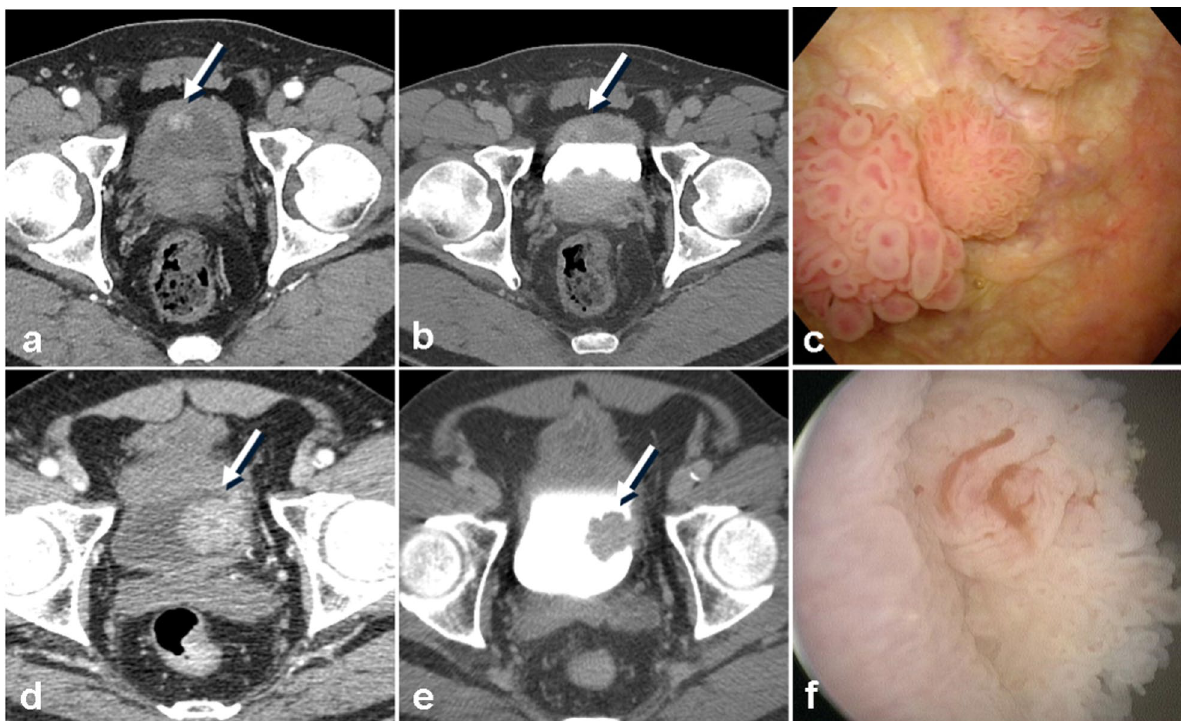
Fig. 1 Urothelial (portal) and excretory (delayed) phase scans of CT urography in two patients of urothelial carcinoma. a Axial urothelial phase CT image of a 63‑year‑old man obtained at 70 s after bolus intravenous contrast material injection shows a small hyper‑enhancing polypoid mass (arrow) that enhances more than normal bladder mucosa. b Axial excretory phase CT image shows the enhancing bladder lesion (arrow) but is less pronounced compared to the urothelial phase. c The nodule was also identified using conventional cystoscopy. d Axial urothelial phase CT image of a 74‑year‑old man shows an intraluminal hyper‑enhancing mass (arrow) on the left wall of the bladder. e Axial excretory phase CT reveals the mass as a filling defect (arrow) within the bladder lumen. f The nodule was also detected using conventional